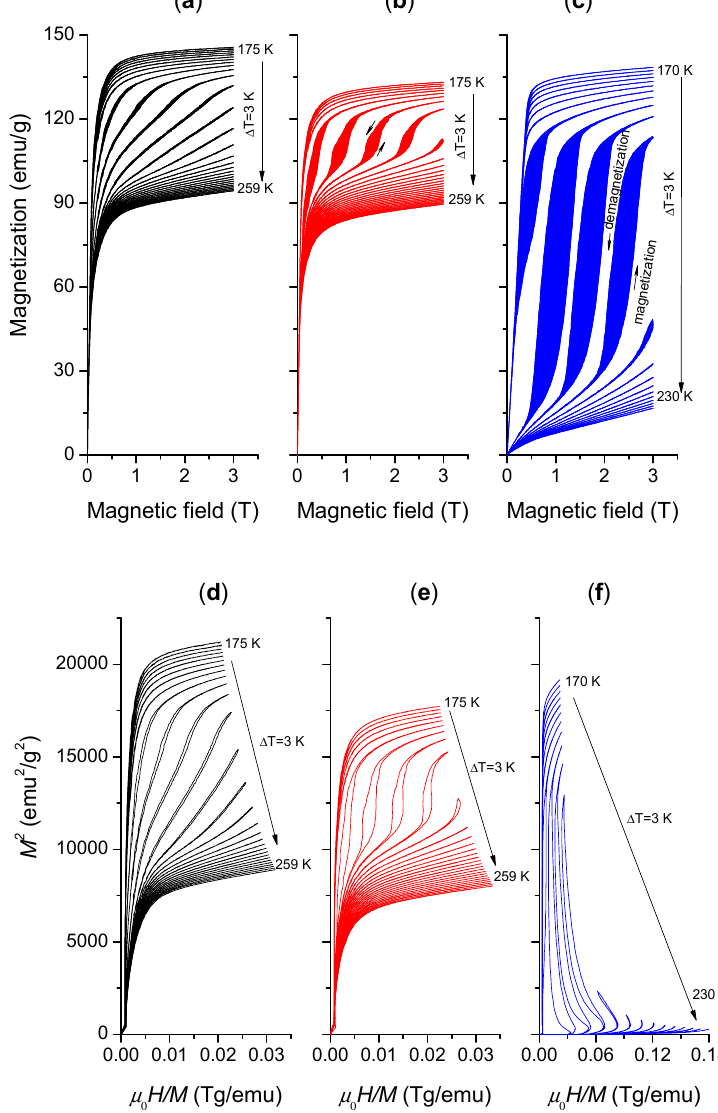
Figure 6. Isothermal magnetization curves for the annealed LaFe 11.6 Si 1.4 ( a ), LaFe 11.6 Si 1.4 Zn 0.03 ( b ), and LaFe 11.6 Si 1.4 P 0.03 ( c ), respectively. Shadowed areas indicate the magnetic hysteresis. Images ( d – f ) are the corresponding Arrott plots.